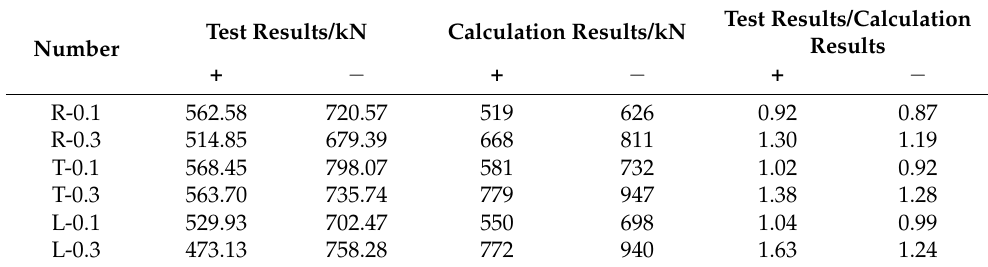
Table 10. Calculation of normal section of precast shear wall